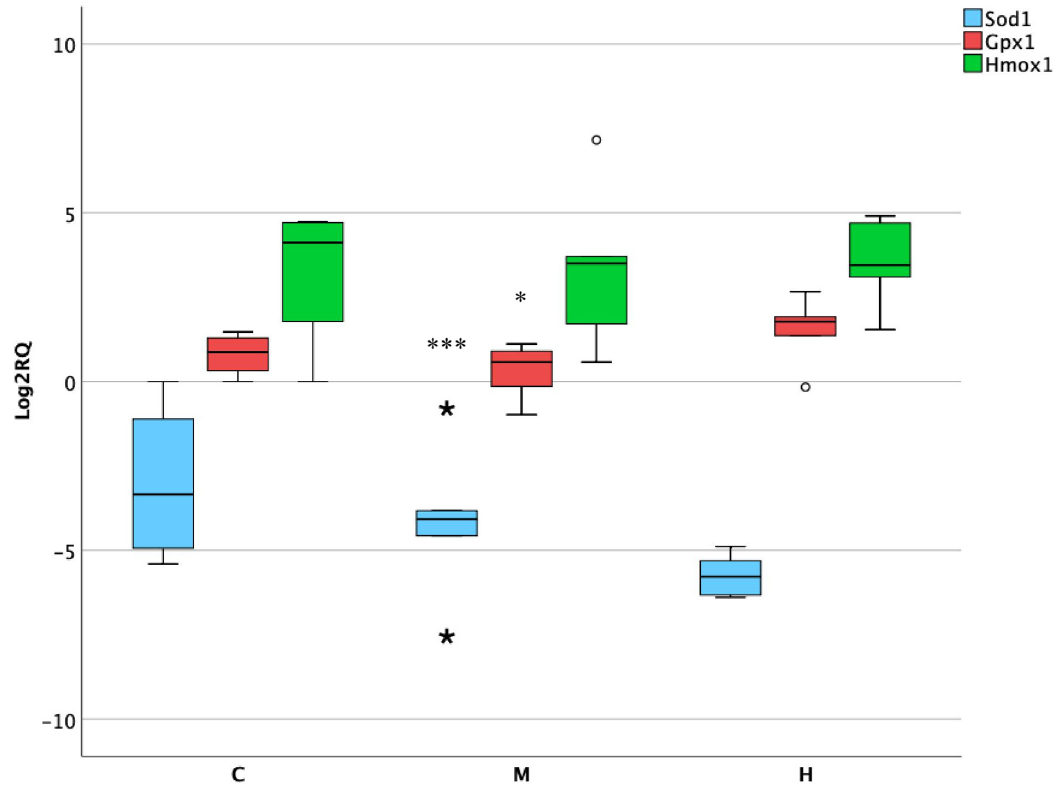
Figure 5. Box plot showing relative expression of oxidative stress genes in lower intestine when compared to control C1 (Log2RQ = 0) to medium treatment (M) and high treatment (H) by qPCR. RQ, relative quantification. The box plots show the median value (horizontal line), the top and bottom edges of the boxes (75% and 25% percentiles), ( ★ ) extreme cases, (o) outliers (atypical values) and whiskers, which are the furthest values away from the boxes that are not considered outliers. * p < 0.05; *** p < 0.001 significantly different from the control.